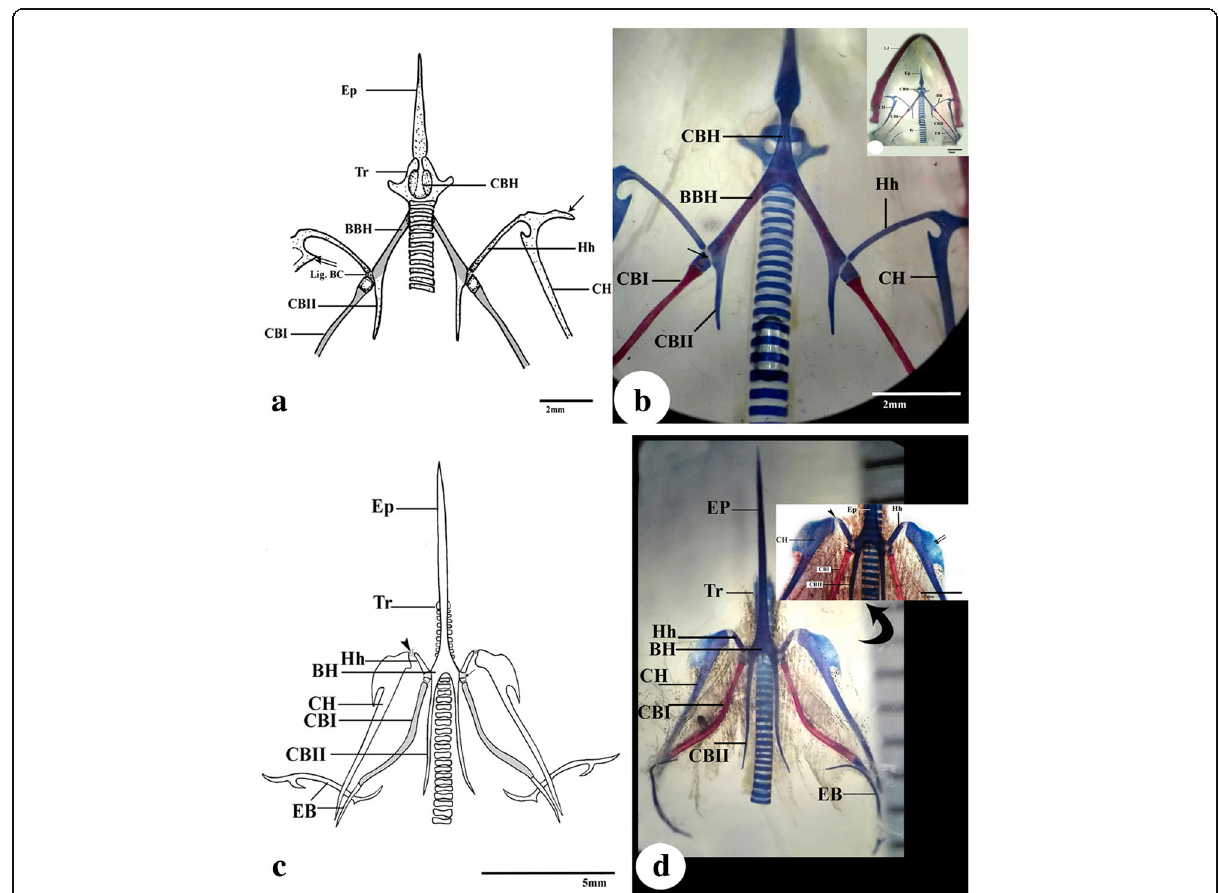
Fig. 1 a Dorsal view and b ventral view of the hyoid apparatus of P. guttatus showing its structure, basi-ceratbranchialis ligament, (Lig.BC), reduced cartilaginous extension (Arrow), and small medial process of the ceratohyalis (double arrows); scale bar 2mm. c , d Ventral view of the hyoid skeleton of A. boskianus showing the basi-ceratobranchialis ligament (arrow) and the cerato-hypohyalis ligament (arrowhead); Scale bar 2 and 5mm. b , d Hyoid skeleton of both studied species stained with Alcian blue and Alizarin red stains showing all cartilaginous processes of the hyoid skeleton exhibited by a blue color while bony element stains by a red color. Ep, entoglossus process; BH, basihyoid; CBH, cartilaginous basihyoid; BBH, bony basihyoid; Hh, hypohyalis; CH, ceratohyalis; CBI, ceratobranchialis I; CBII, ceratobranchialis II; Tr,